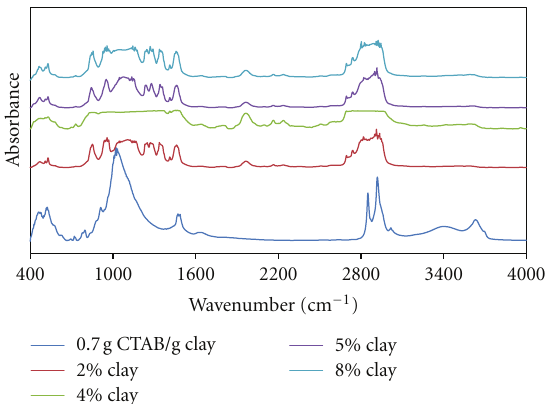
Figure 8: FTIR spectra of produced PEO/clay nanocomposites at various clay compositions (0.1g CTAB/g clay ratio).